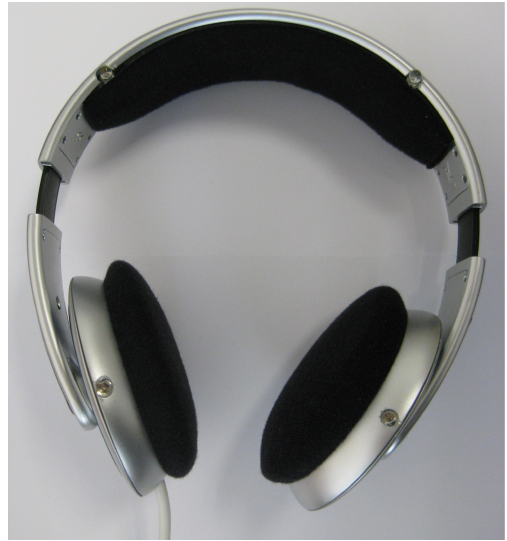
Figure 7. Headphones with integrated infrared